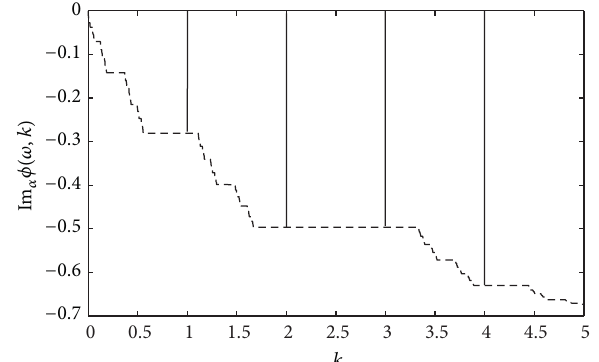
Figure 2: The graph of Re 𝛼 𝜙(𝜔,𝑘) with premasters 𝜔 = 1 and 𝛼 = ln 2/ ln 3 .